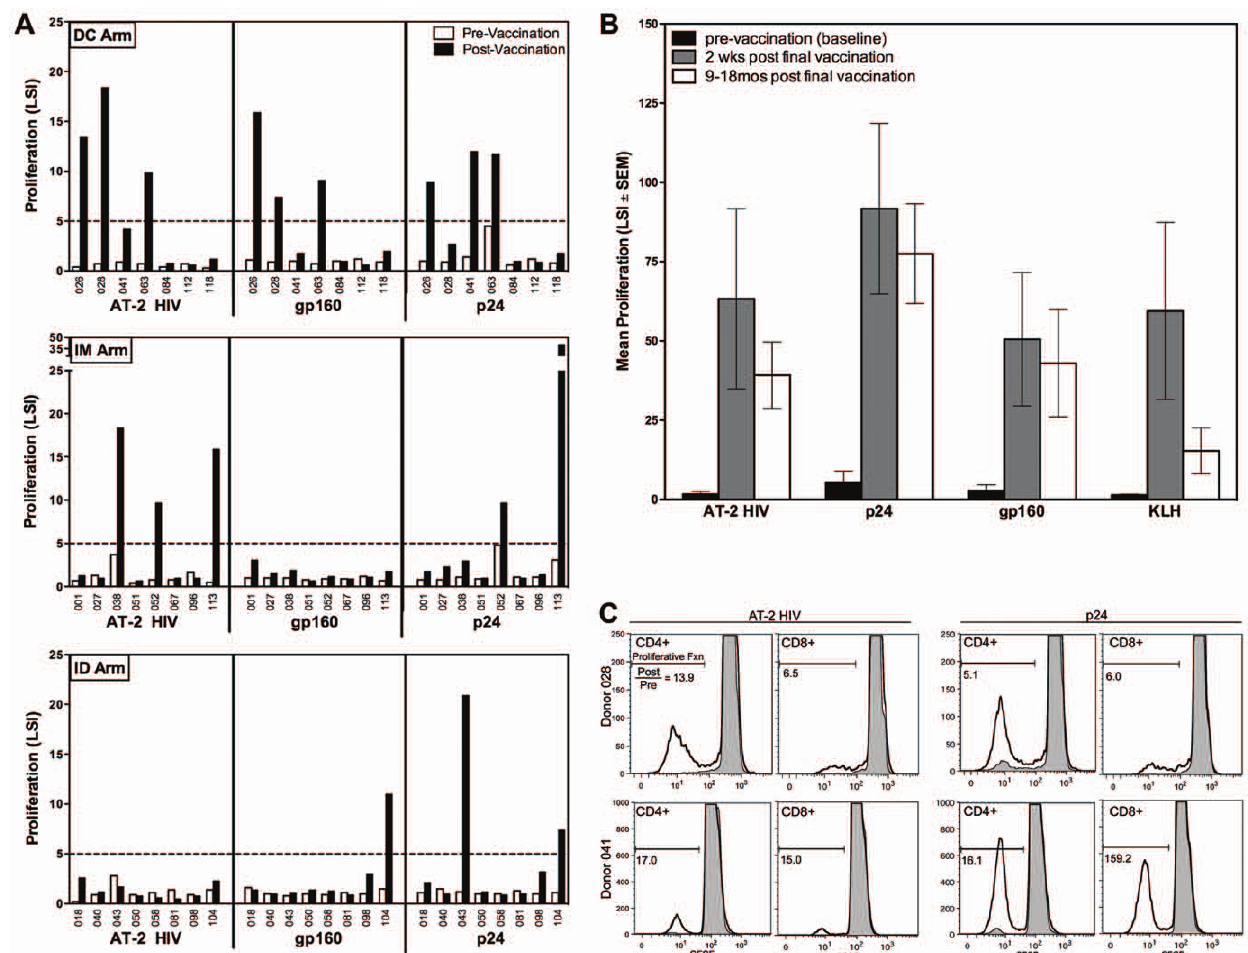
Figure 4. HIV specific lymphocyte proliferation responses. LPA responses of PBMC from (A) pre-vaccination (v.1, white bars) and two weeks post final vaccination (v.11, black bars) from all vaccinees. Responses to whole inactivated HIV (AT-2 HIV), HIV-gp160 and HIV-p24 were measured and reported as a lymphocyte stimulation index (LSI, antigen response/unstimulated control). An LSI of . 5 (dashed line) is considered positive. (B) Durability of proliferative responses up to 18 months post final vaccination for the 4 responders in the DC vaccination arm. Responses to HIV antigens, keyhole limpet hemocyanin (KLH, positive control for DC injection) and aldrithiol-2 microvessicles (MV, negative control for AT-2 HIV) are expressed as mean LSI 6 SEM from LPAs performed on fresh PBMC. (C) Proliferative responses pre-vaccination (grey histograms) and 2 weeks post final vaccination (black lines) to HIV antigens were measured by flow cytometry using CFDA-SE. CD4 + and CD8 + T cell responses are shown for two donors from the DC arm stimulated with either AT-2 HIV (left panels) or HIV-p24 (right panels). Proliferative response is measured as the percent of cells that have undergone division and show reduced intensity of CFSE. The ratio of proliferative response post-vaccination to pre-vaccination is shown.